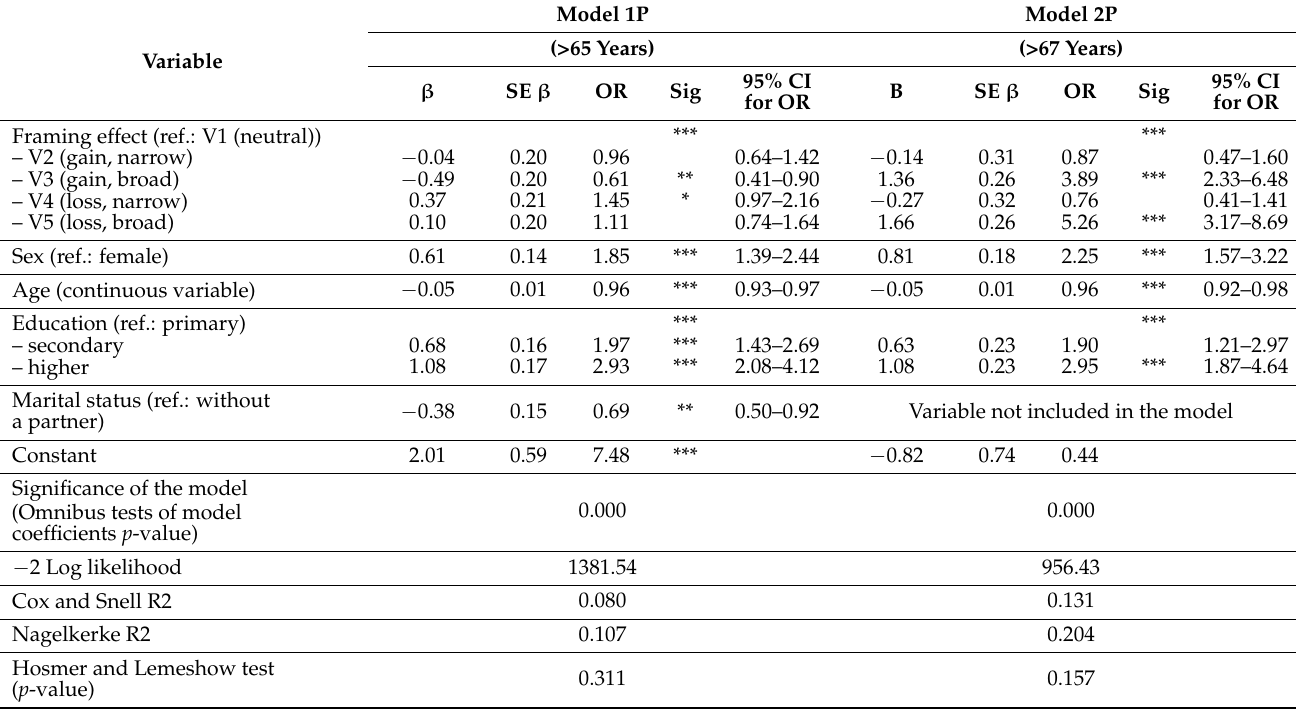
Table 5. Logistic Regression Models of Planned Retirement Age (Whole